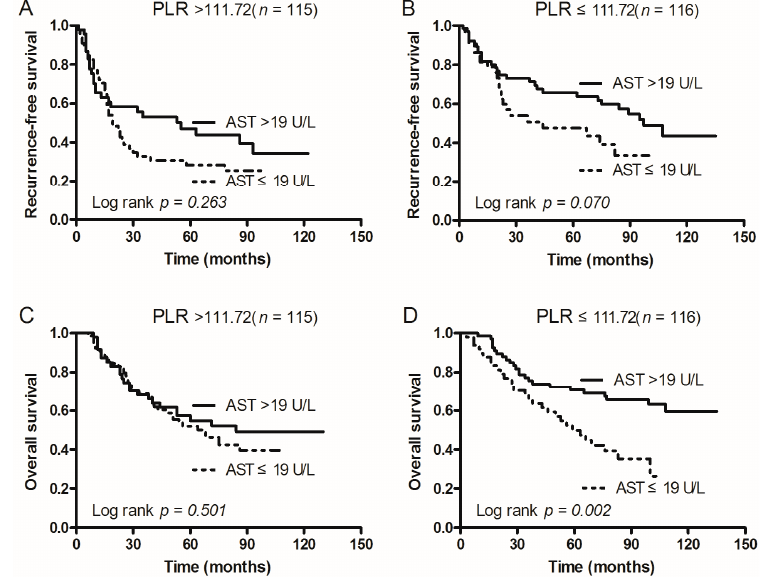
Figure 4. Kaplan–Meier survival curves of patients with AST > 19 U/L and AST ≤ 19 U/L grouped by patient subgroups of PLR. ( A ) In PLR > 111.72 patients, RFS of patients with AST ≤ 19 U/L was shorter than that of those with AST > 19 U/L ( p = 0.263); ( B ) In PLR ≤ 111.72 patients, RFS of patients with AST ≤ 19 U/L was shorter than that of those with AST > 19 U/L ( p = 0.070); ( C ) In PLR > 111.72 patients, OS of patients with AST ≤ 19 U/L was shorter than that of those with AST > 19 U/L ( p = 0.501); ( D ) In PLR ≤ 111.72 patients, OS of patients with AST ≤ 19 U/L was shorter than that of those with AST > 19 U/L ( p = 0.002).